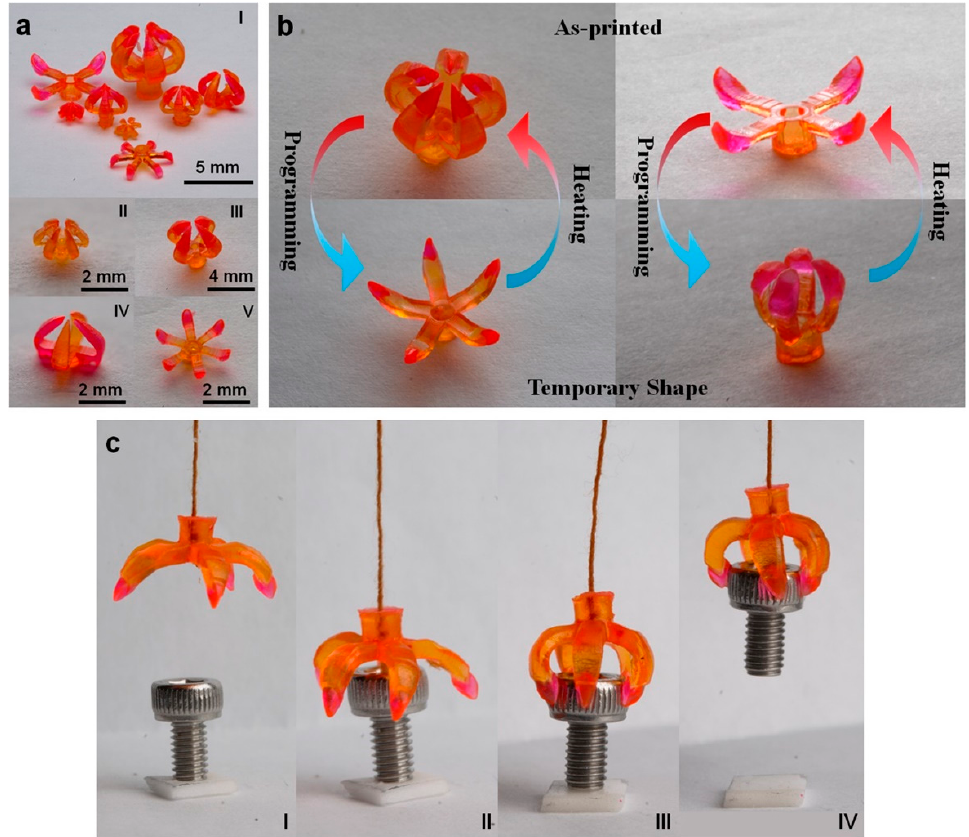
Figure 17. Different designs to construct multi ‐ material grippers. ( a ) The illustration of the transformation of multi ‐ material grippers from their printed shape to the temporary shape. ( b ) The transition of the grippers from their printed shape to their temporary shape upon heating. ( c ) The snapshots depict several stages of the process of gripping an object. Figure reproduced with permission from [197].